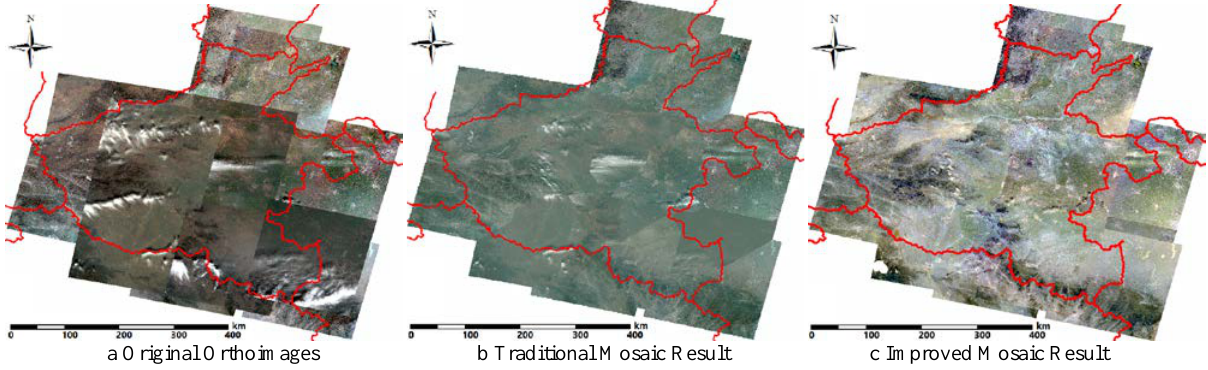
Figure 6. Henan’s GF-1 wide-field-of-view images